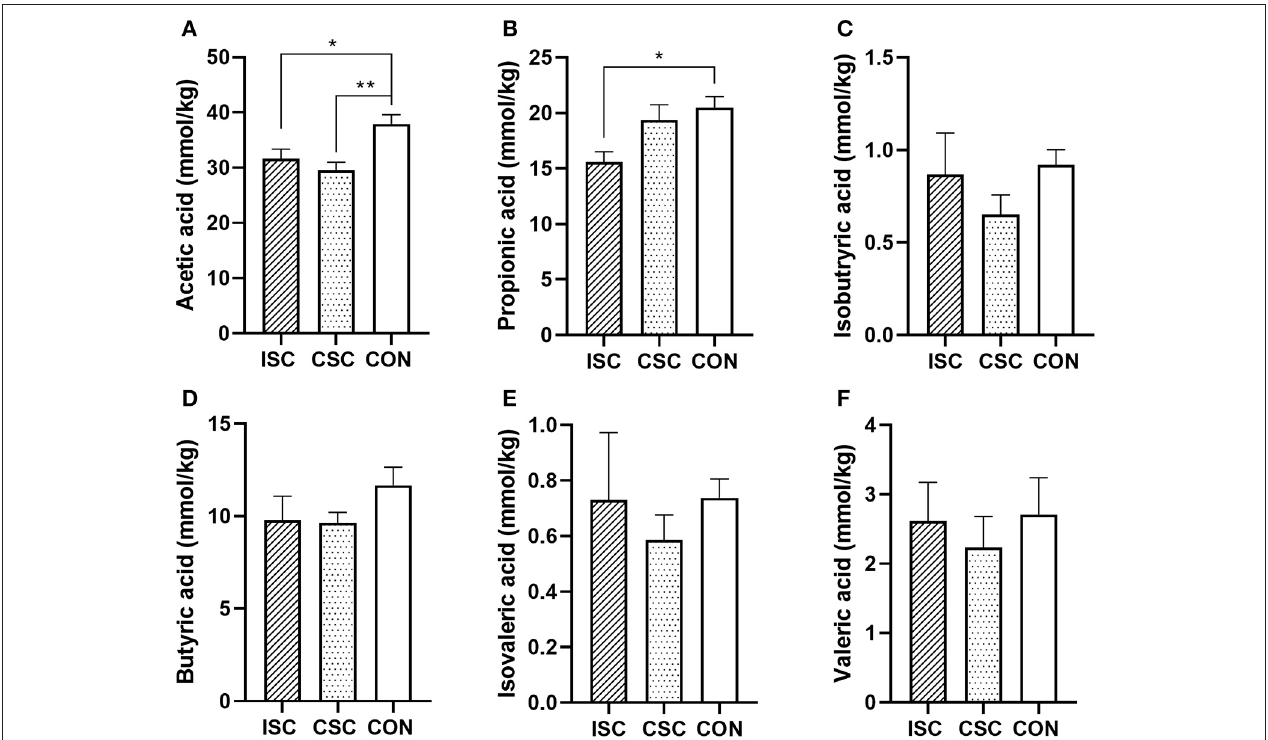
FIGURE 5 | The concentration of SCFAs in the colonic content of piglets. (A) Acetic acid. (B) Propionic acid. (C) Isobutyric acid. (D) Butyric acid. (E) Isovaleric acid. (F) Valeric acid. n = 6, * p < 0.05 and ** p < 0.01. SCFAs, short-chain fatty acids; ISC, intermittent social contact; CSC, continuous social contact; CON,